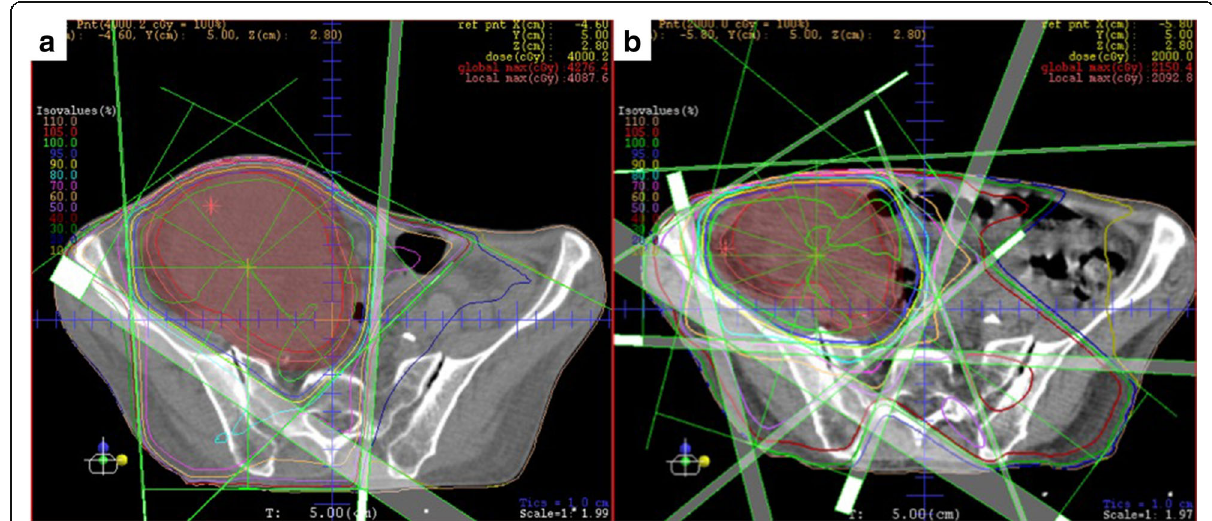
Fig. 3 The image of radiation treatment planning system: an axial view of dose distribution. a We prescribed the initial dose of 40 Gy in 20 fractions with three-field technique. b After reconstituting the radiation field conforming with the shrunken tumor, we boosted the additional dose of 20 Gy in 10 fractions with five-field technique